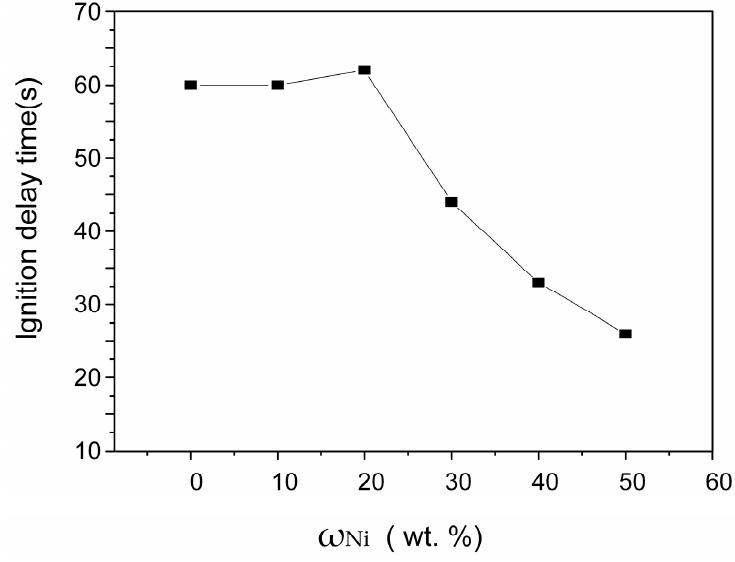
Figure 5. Variation in the ignition delay time ( t ig ) with various Ni contents.